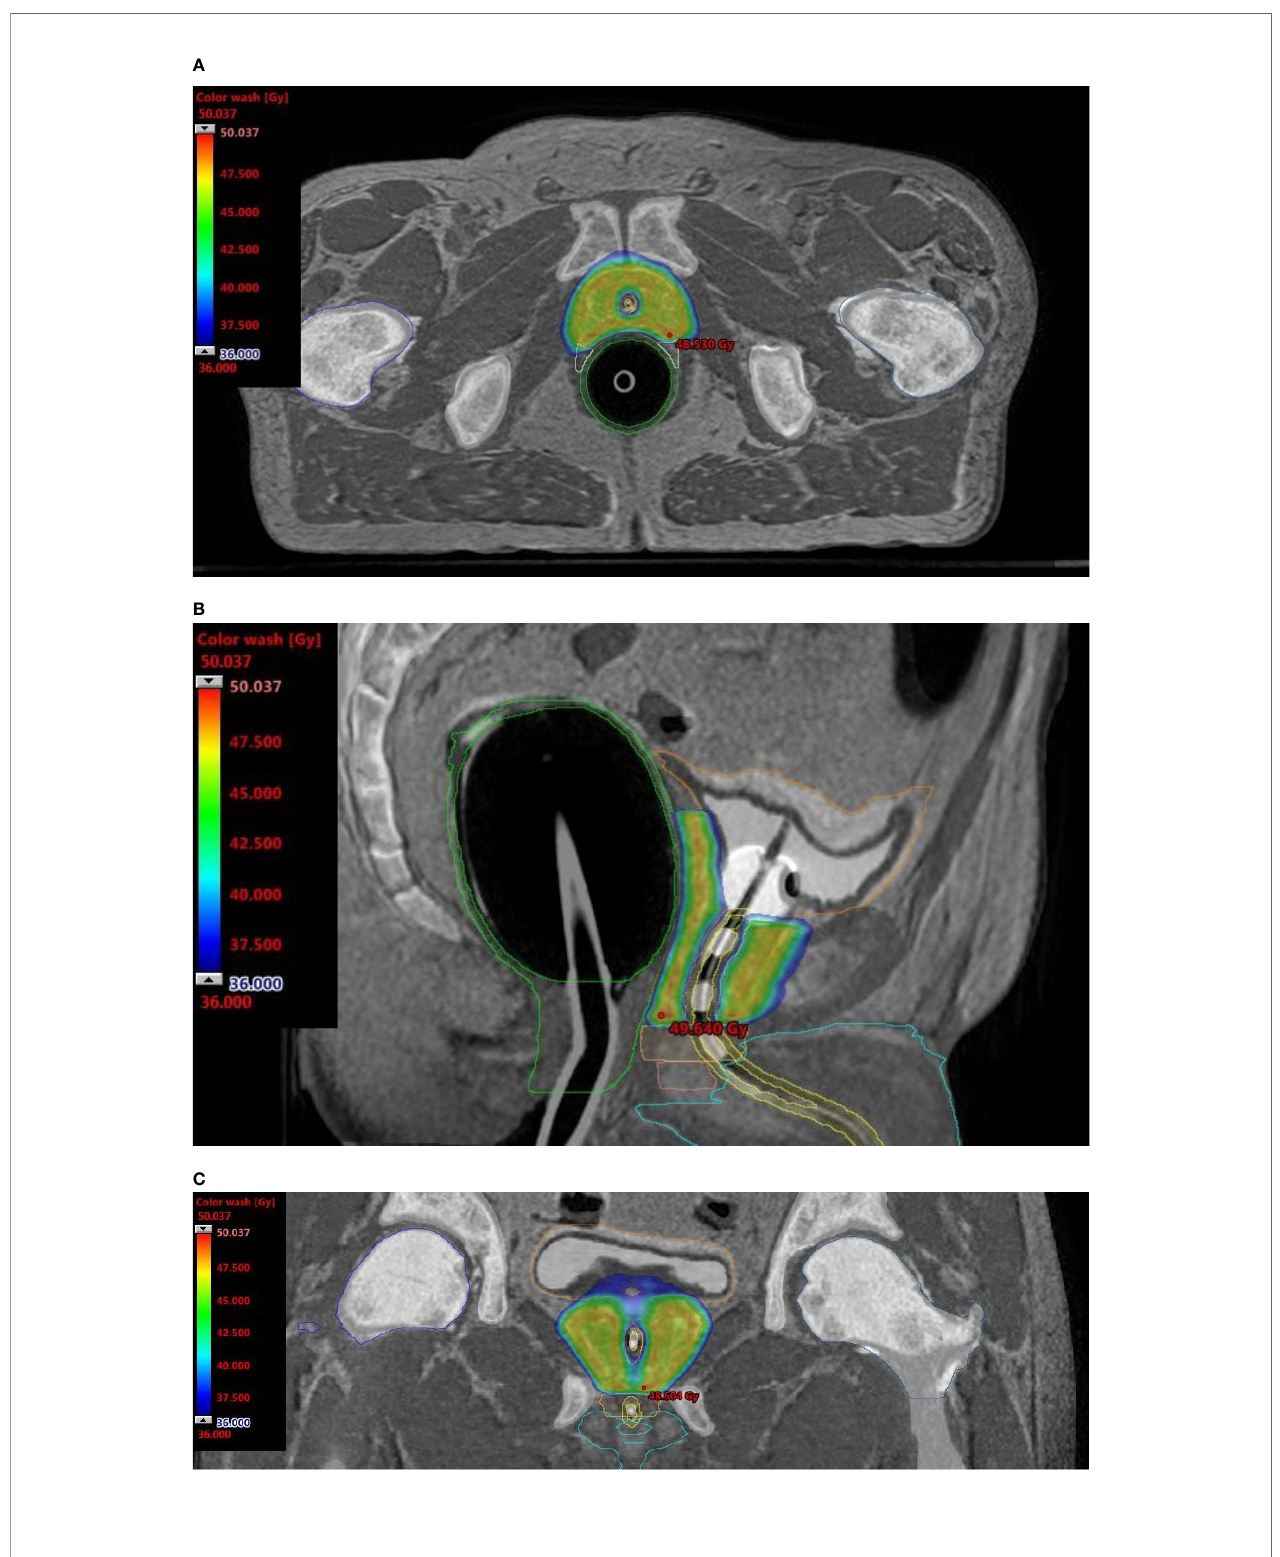
FIGURE 1 | Dosimetric plans of a patient treated with rectal distension-mediated 5 × 9 Gy extreme hypofractionated SABR. Fused CT-MR image sets show dose- sculpted distributions along the urethra, rectal wall, urogenital diaphragm, and neurovascular bundles. Color-wash dose distributions are shown on the axial (A) , sagittal (B) , and coronal (C) planes. An intraurethral Foley catheter loaded with 3 beacon transponders is visible on the longitudinal